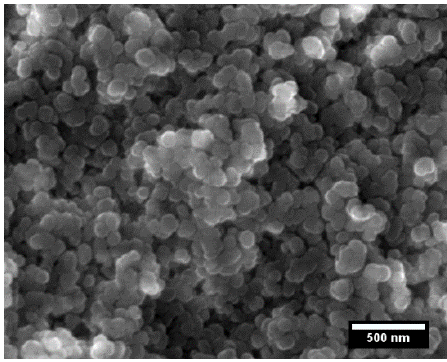
Figure 1. Scanning electron microscope (SEM) image of magnesium aluminate spinel powder.